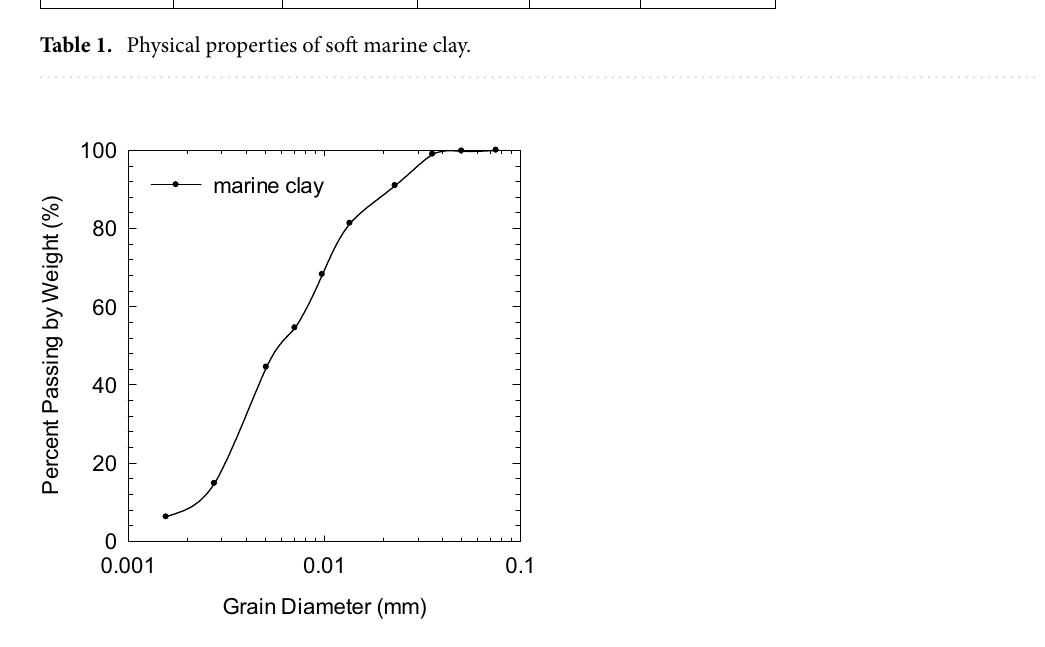
Figure 1. Grain size distribution of marine